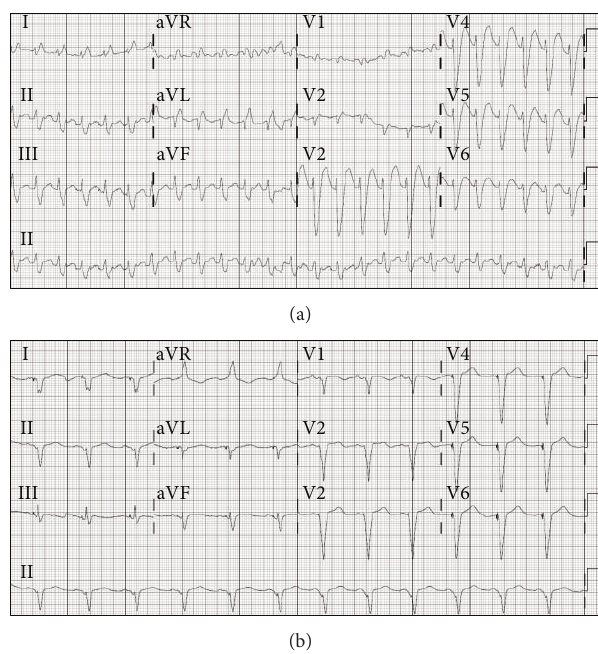
Figure 1: (a) Ventricular tachycardia shortly after arrival of the patient to the emergency department. (b) Restoration of sinus rhythm, with atrial-tracking ventricular pacing following intubation and amiodarone treatment.